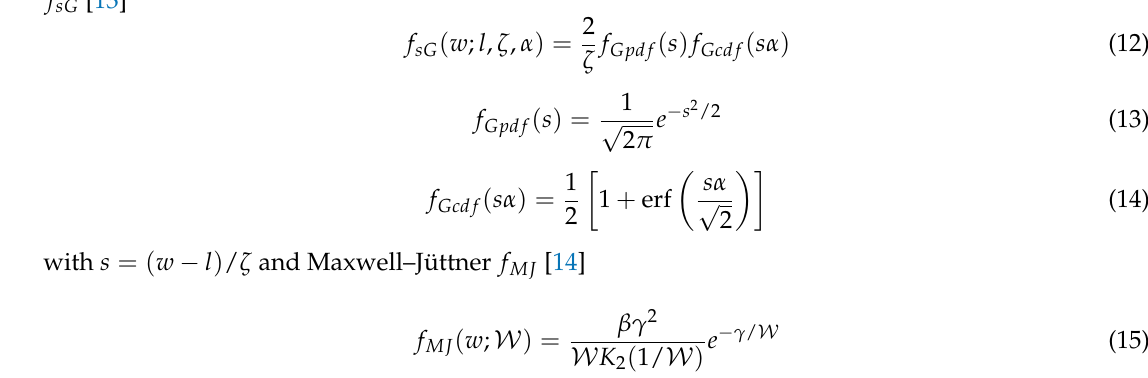
(cid:10) (cid:11) = β 2 γ